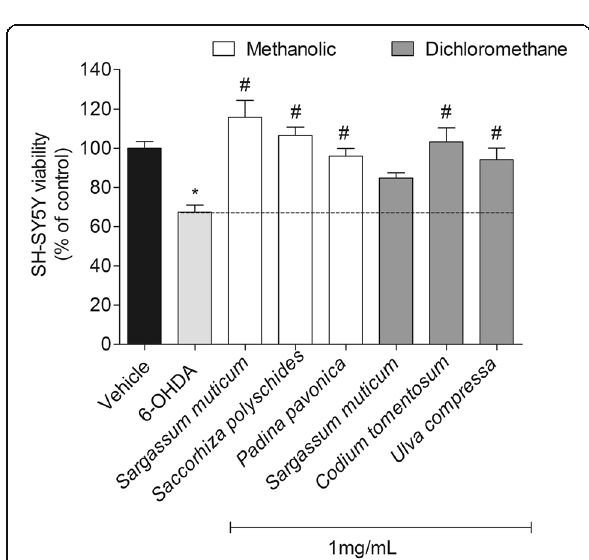
Fig. 2 Neuroprotective effects of seaweeds extracts (1 mg/mL) on SH-SY5Y cells exposed to 6-OHDA (100 μ M). Determination of cell viability by the MTT method (% control) after 24 h of incubation. Values are mean±SEM (n=16). Symbols represent statistically significant differences ( p <0.05, ANOVA, Dunett ’ s test) when compared